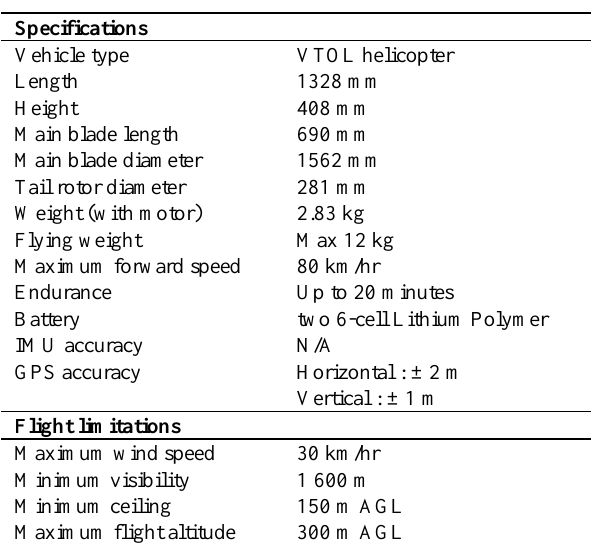
Table 1. UAV specifications and flight limitations